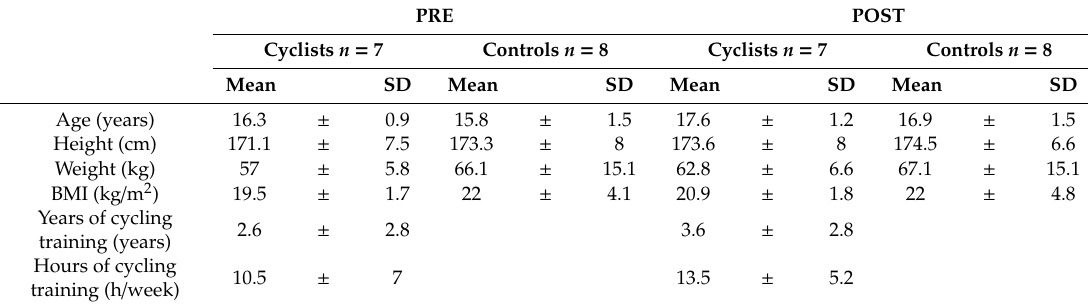
Table 1. Descriptive characteristics of the sample. BMI, body mass index; SD, standard